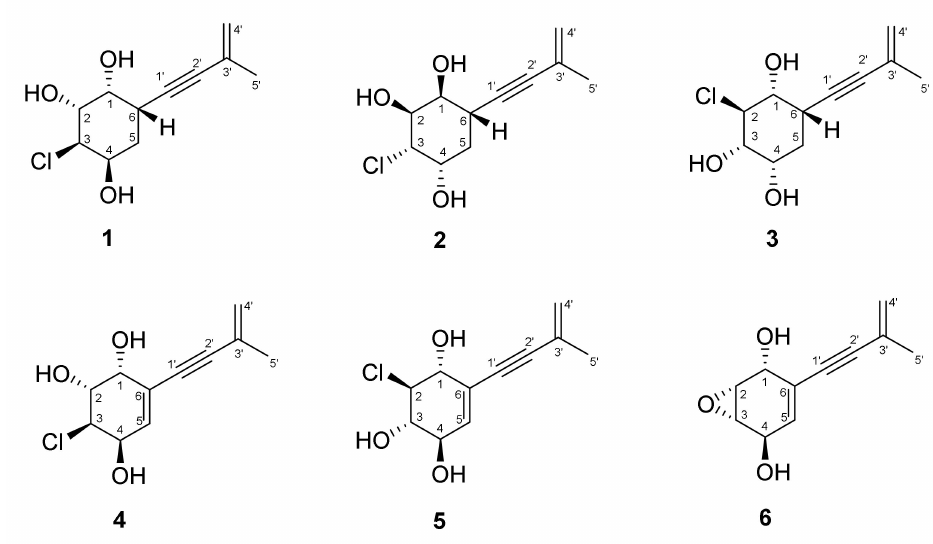
Figure 1. Chemical structures of 1 – 6 .